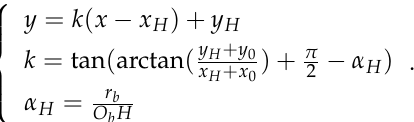
Figure 3. The spot shape when laser beam is off ‐ center.